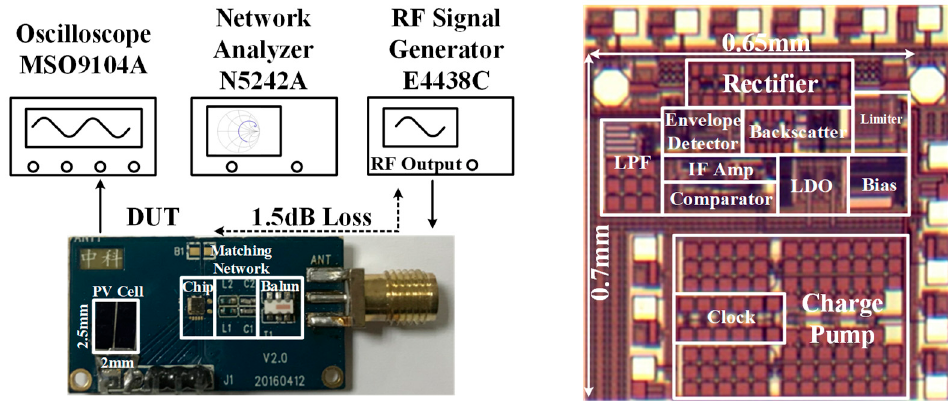
Figure 14. Measurement setup and microphotograph of the implemented chip.